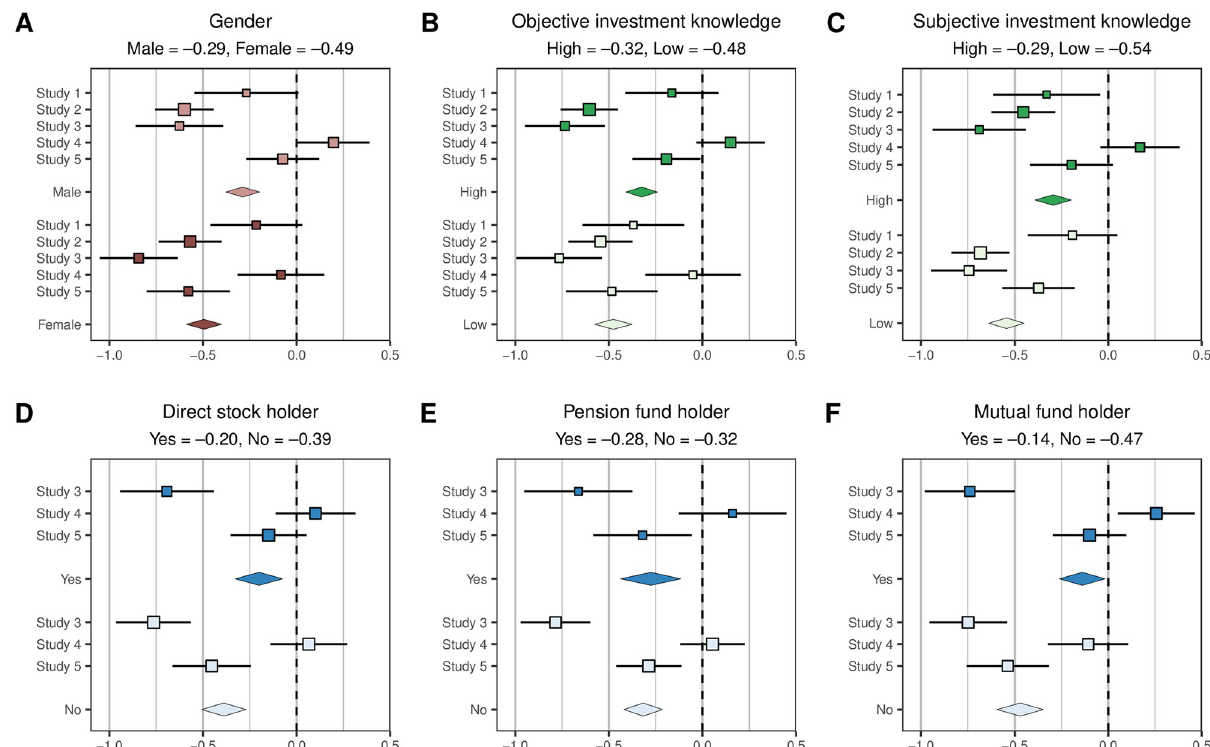
Fig 1. Robo-investment aversion across subsamples. Effects sizes are presented as Cohen’s d s. Mean effect sizes are fixed effects, computed using the R package metaviz [58,59].Error bars correspond to 95% confidence intervals. All mean subgroup effects are significant at the 5% level.